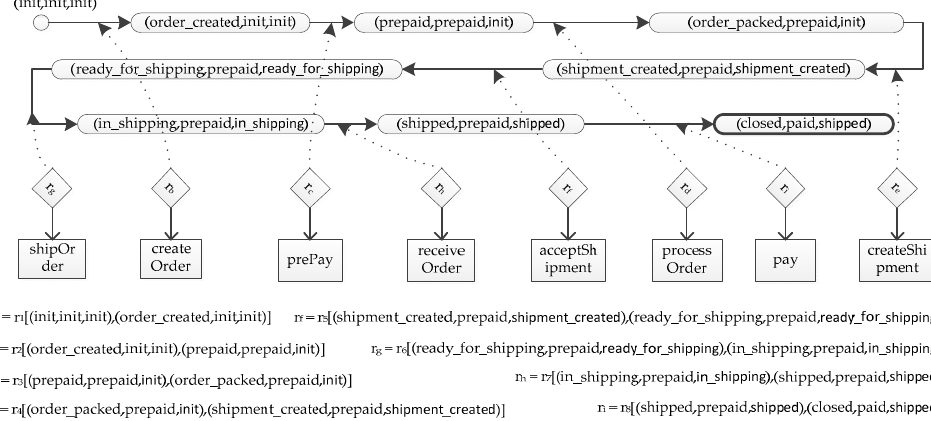
Figure 4. The lifecycle of the purchase business process model M P (Figure 1).